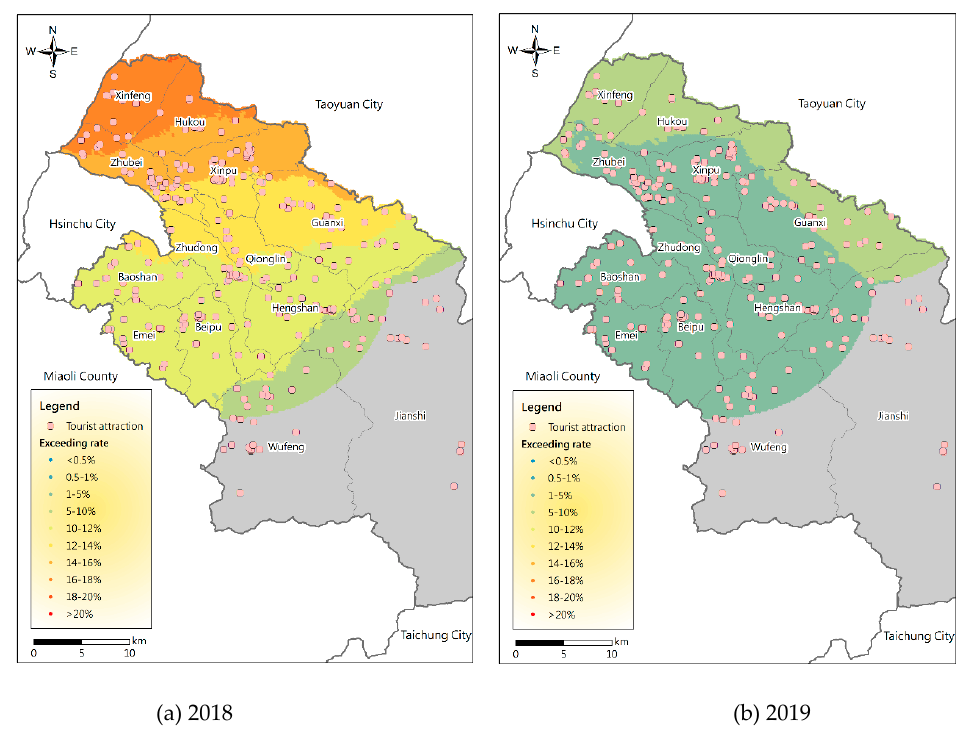
Figure 8. Dynamic distribution of PM 2.5 potential in tourist areas in Hsinchu County in spring in ( a ) 2018 ( b ) 2019.